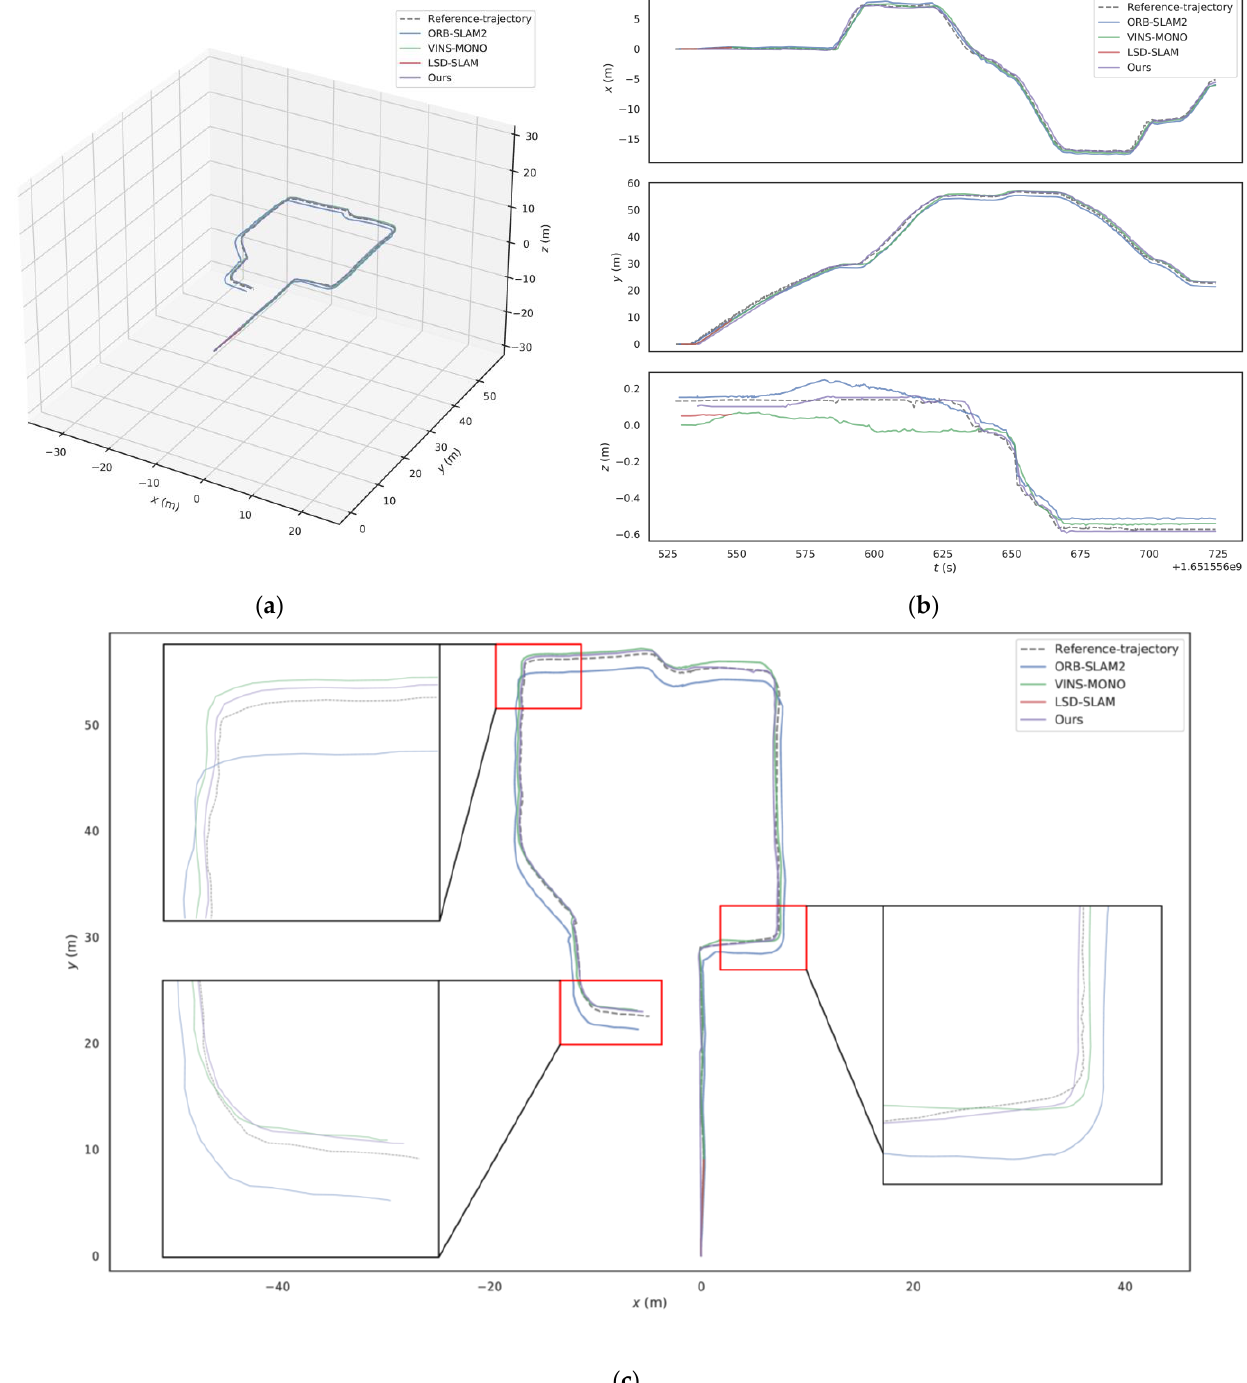
Figure 13. Results of the unclosed trajectory experiment: ( a ) the trajectories of the proposed method (purple) and each comparison group; ( b ) the accuracy of the three coordinate axes of each method; ( c ) the projection of the trajectory of each algorithm to the xy-plane.